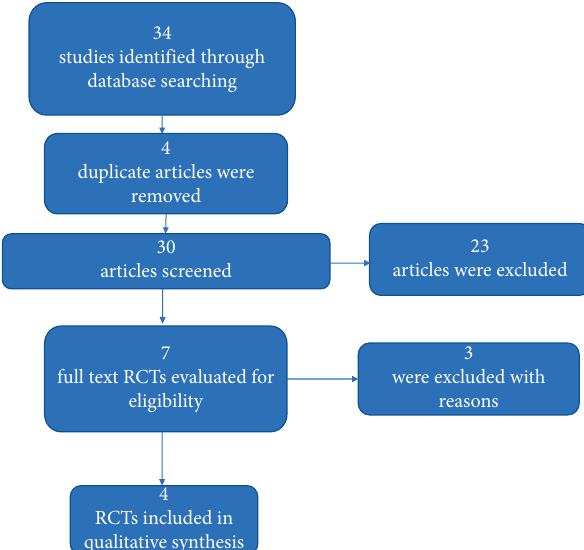
Figure 1: Flowchart of the RCTs selection